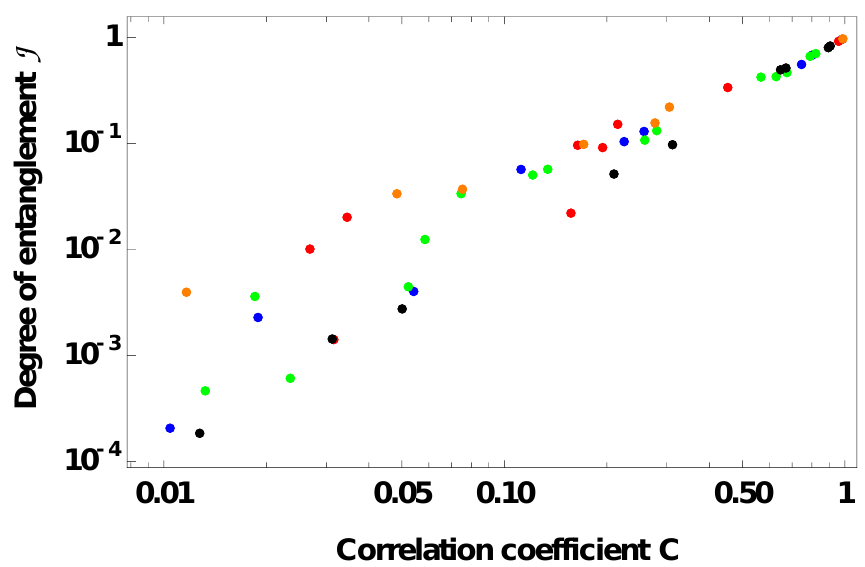
Figure 6: Relation between the degree of entanglement (4) and the photon-number correlations (3) for the 5 typifying frequencies of Fig.3 ( a - e ). Blue — low ω (cf. a ); red — WHI (cf. b ); green — medium ω (cf. c ); orange — BHI (cf. d ); black — high ω (cf. e ). α a positive norm